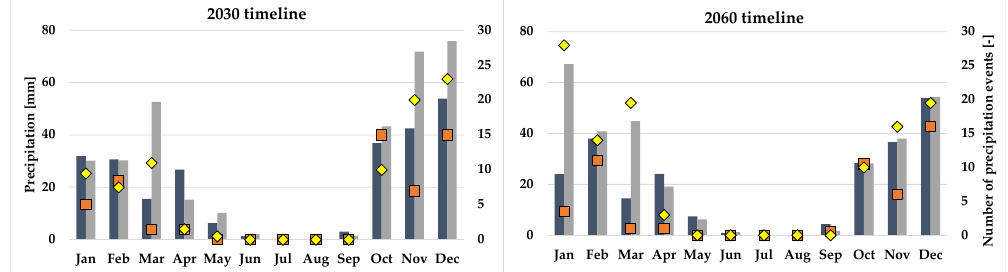
Figure 6. The monthly average precipitation (mm) for each climate model (bars), and the number of daily precipitation events >10 mm ( − ) for all period (symbols), for each timeline. Table 5. The monthly averages for river flow (m 3 s − 1 ), total N (mg N L − 1 ), and total P (mg P L − 1 ) in each